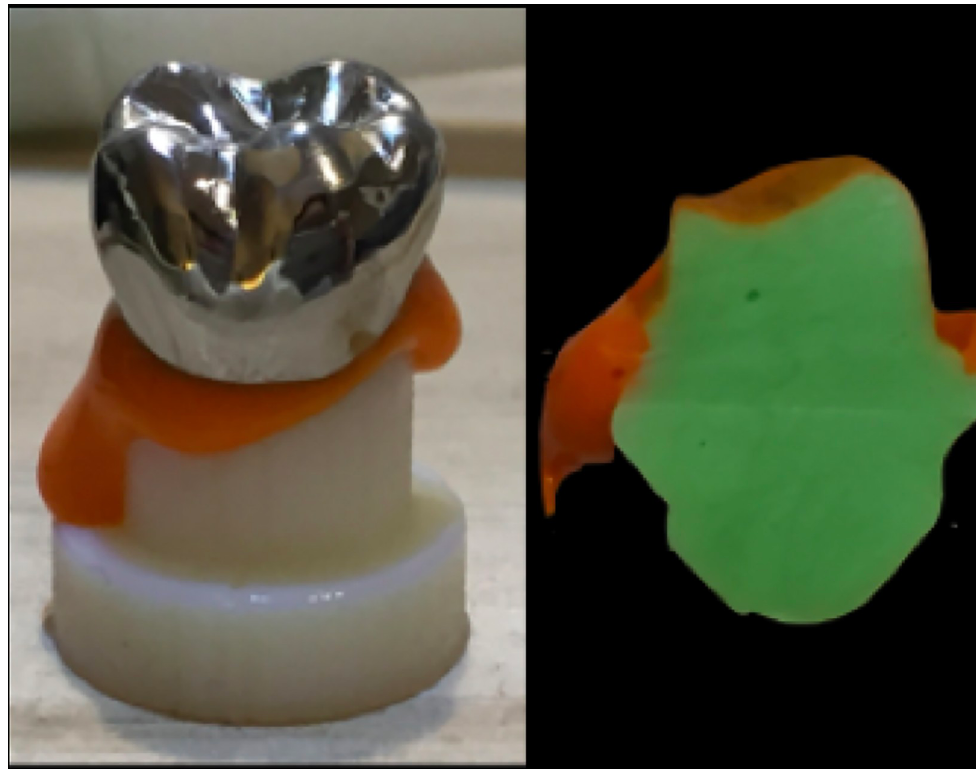
Fig 4. Silicone replica